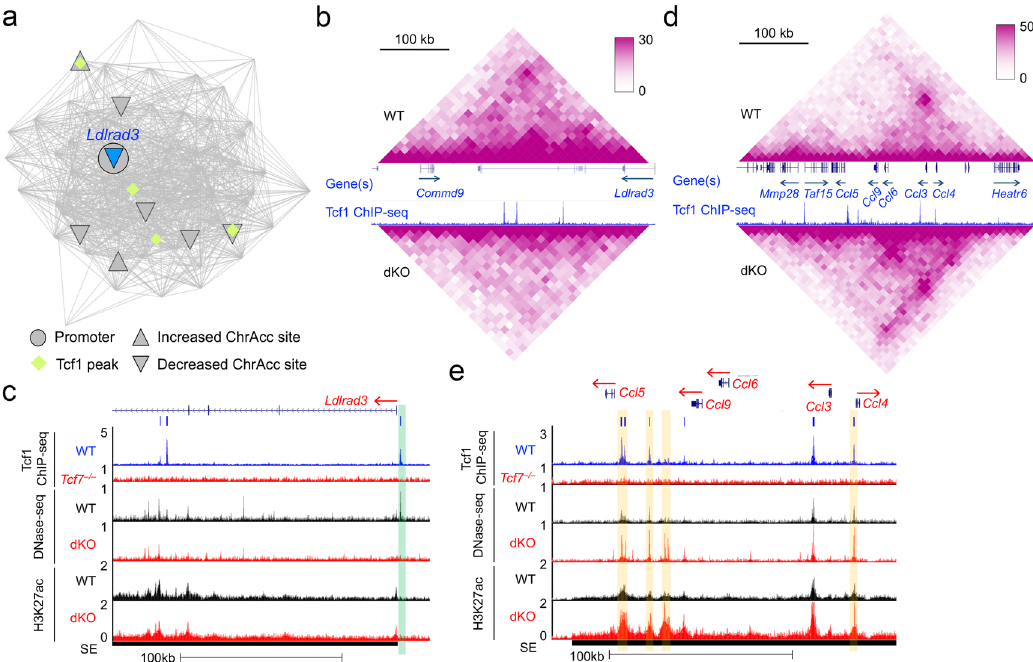
Fig. 8 Tcf1/Lef1 TFs repress CD8 + lineage-inappropriate genes through modulating chromatin interactions. a – c Tcf1 and Lef1 repress Ldlrad3 by promoting chromatin interactions. a network display of a WT-speci fi c hub containing the Ldlrad3 gene. b 2D display of changes in chromatin interactions within the Ldlrad3 -containing hub in WT and dKO CD8 + T cells. c 1D display of changes in ChrAcc and H3K27ac within the Ldlrad3 -containing hub in WT and dKO CD8 + T cells. Green vertical bar denotes a ChrAcc site showing reduction in dKO cells. d , e Tcf1 and Lef1 repress Ccl genes by disengaging chromatin interactions, with the network display of a dKO-speci fi c hub containing the Ccl genes in Fig. 7c. d 2D display of changes in chromatin interactions within the Ccl gene-containing hub in WT and dKO CD8 + T cells. e 1D display of changes in ChrAcc and H3K27ac within the Ccl gene-containing hub in WT and dKO CD8 + T cells. Yellow vertical bars denote ChrAcc sites showing increase in dKO